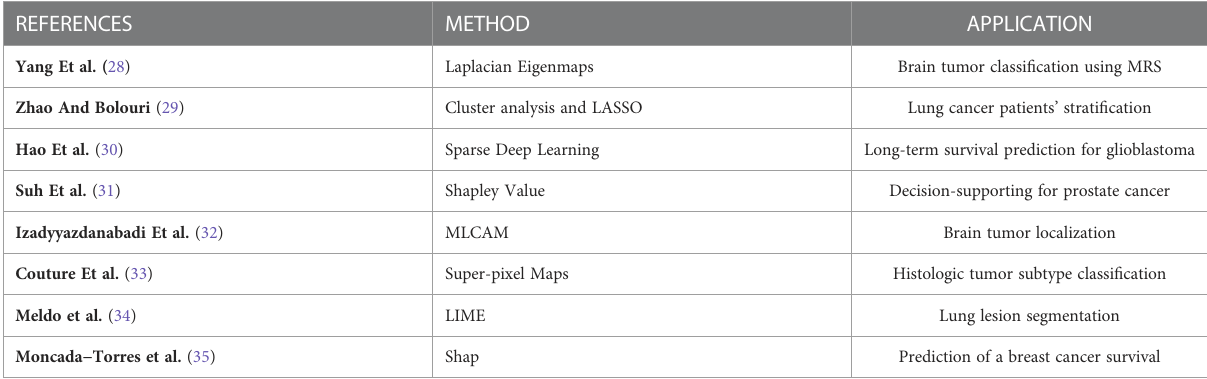
TABLE 7 Summary of XAI application in cancer – related